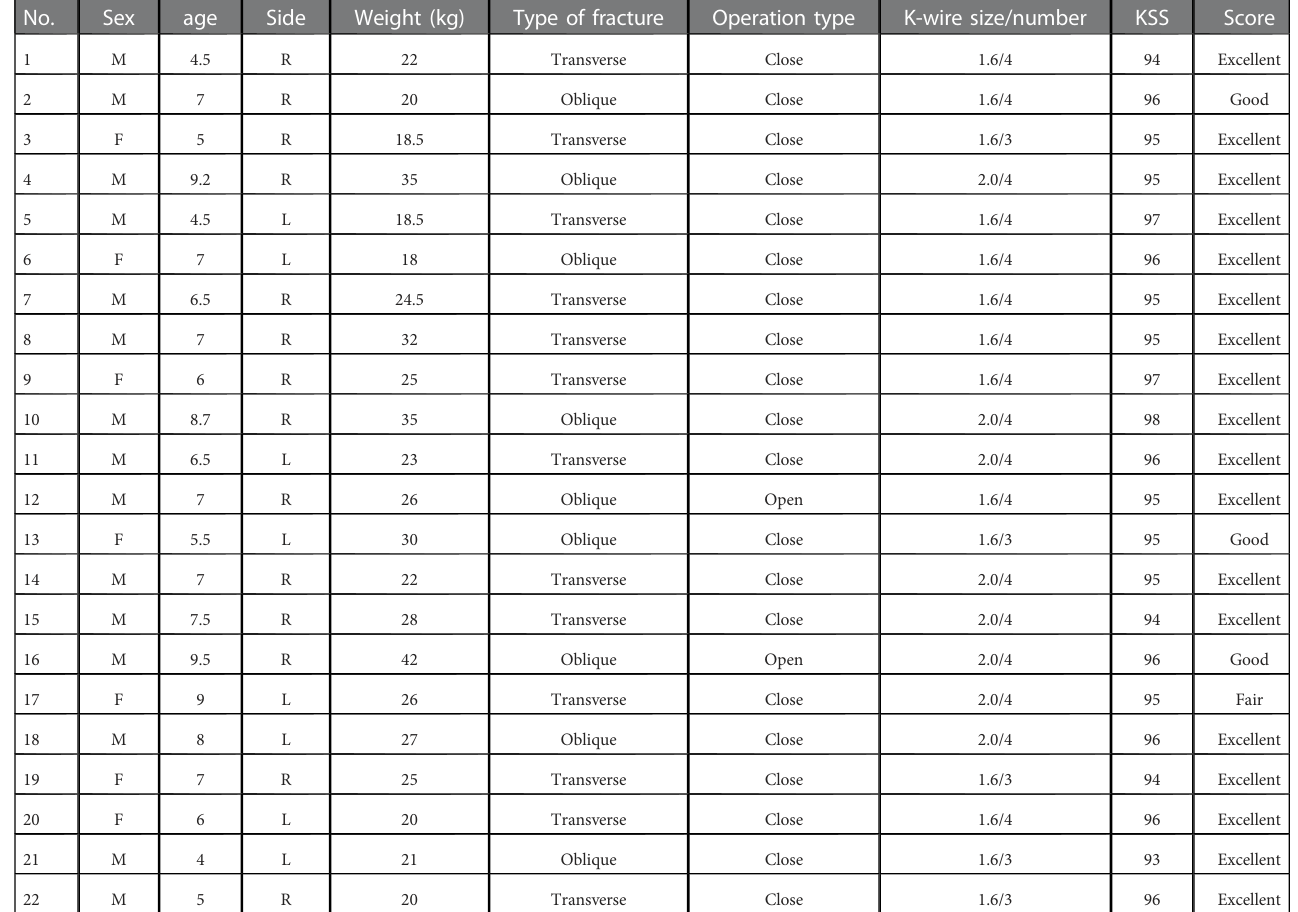
TABLE 1 Characteristics of patients with supracondylar femoral fractures treated by K-wires.